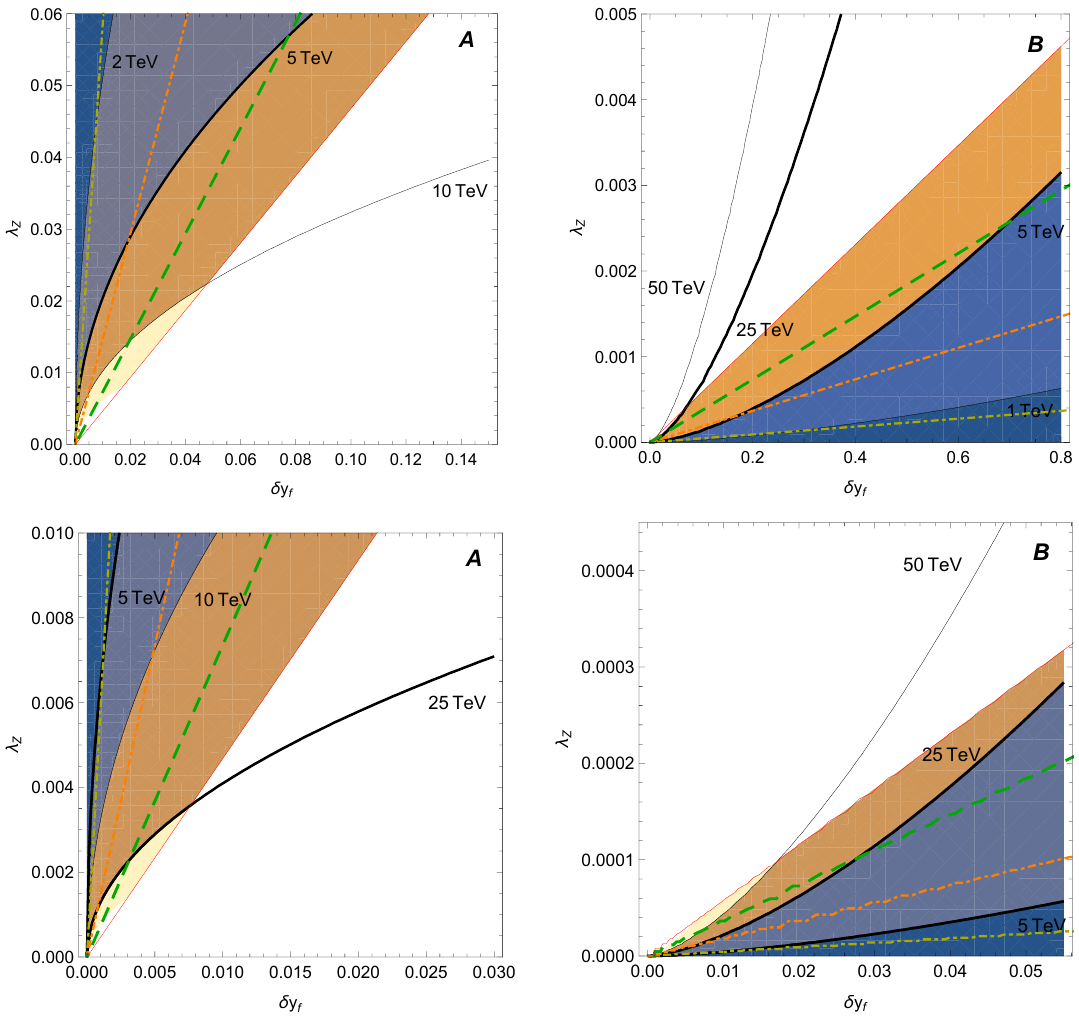
Figure 3 . Estimated (maximal) NP mass M max in dependence on the variation in the Yukawa couplings ( (cid:14)y f ) and the triple-gauge coupling ( (cid:21) Z ) in Scenario A (left) and B (right). The colored lines denote NP couplings of g (cid:3) = 1 ; 4 ; 8 ; 4 (cid:25) , respectively (from yellow to red), and the lower panel shows a zoom into the plots of the upper panel. See text for